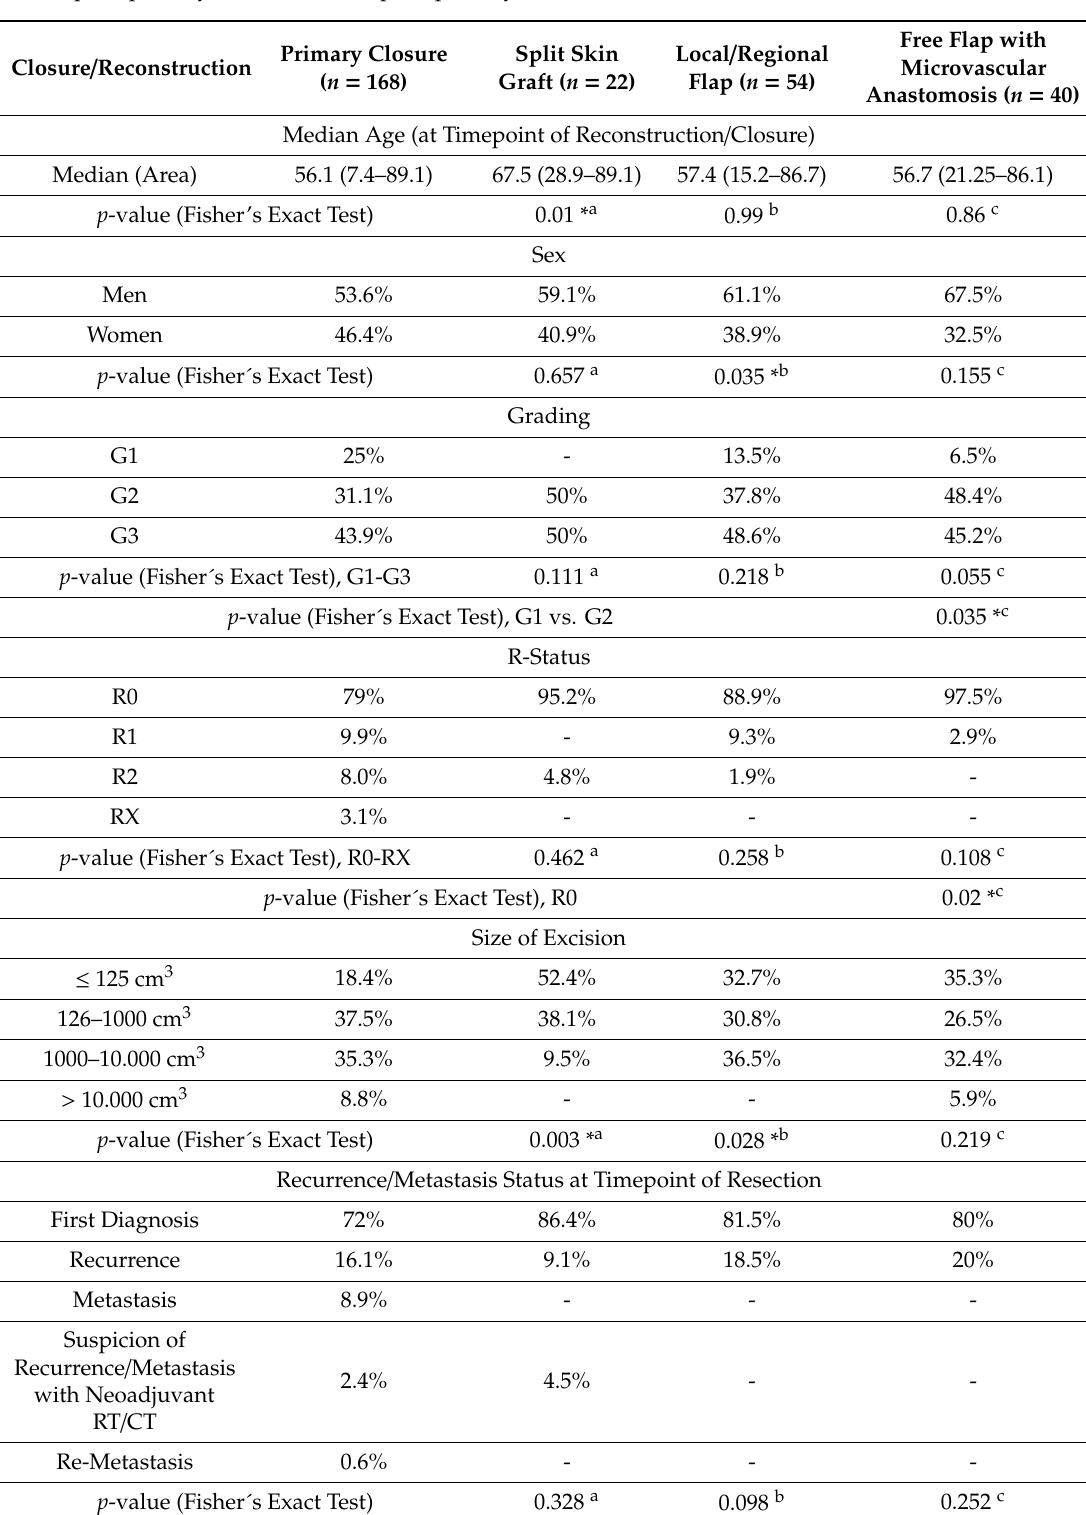
Table 4. Characteristics of four di ff erent groups of closure / reconstruction techniques used. * indicates statistical significance ( p ≤ 0.05). a group of split skin graft vs. group of primary closure; b local / regional flap vs. primary closure; c free flap vs. primary